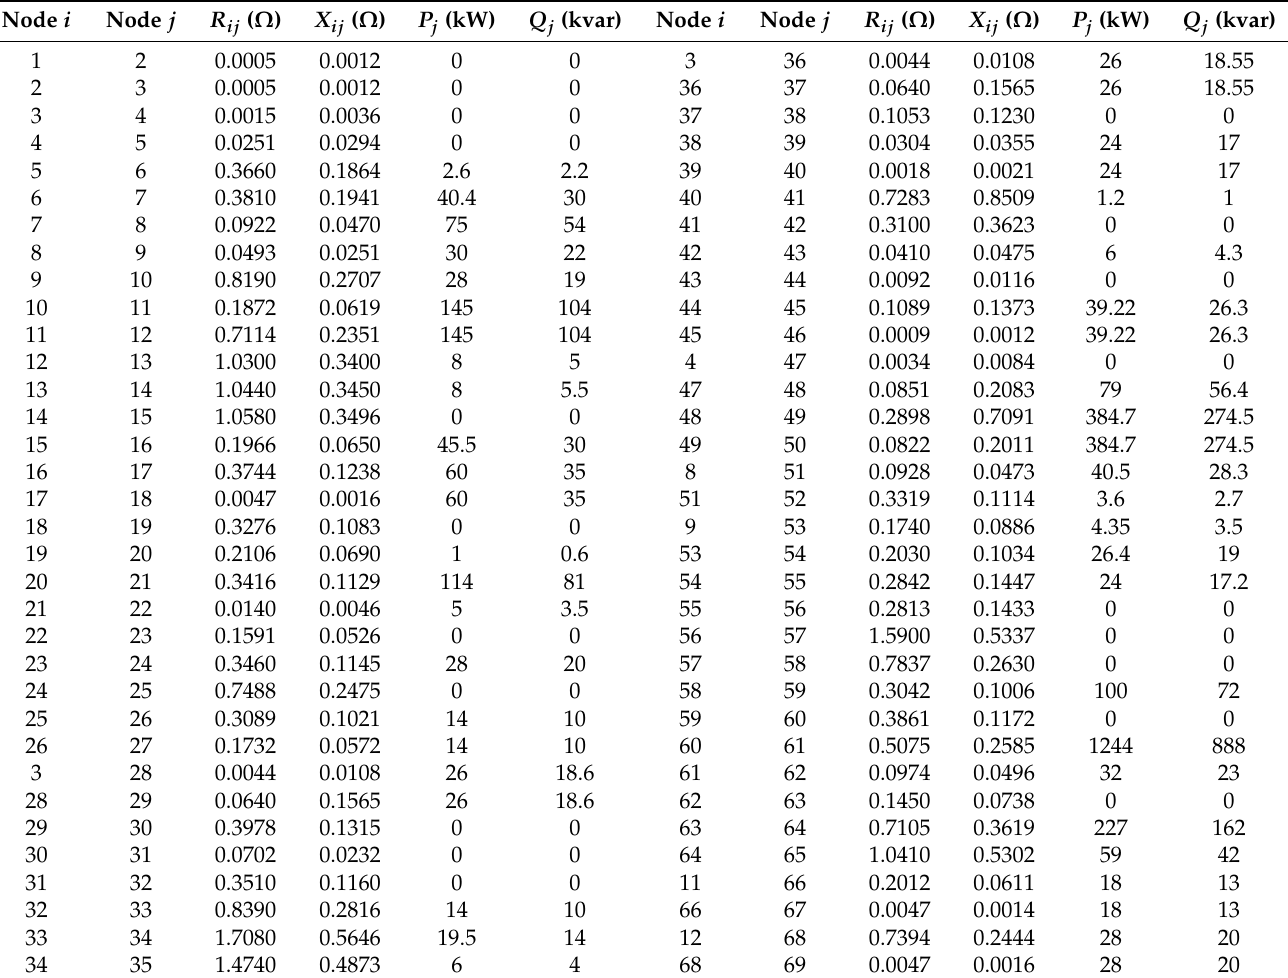
Table 3. Parametric information for the IEEE 69-bus system.